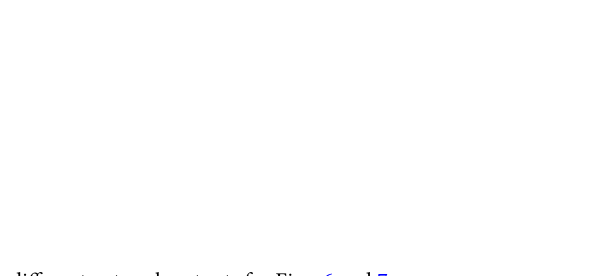
Table 2. Quantitative results associated with different network outputs for Figs. 6 and